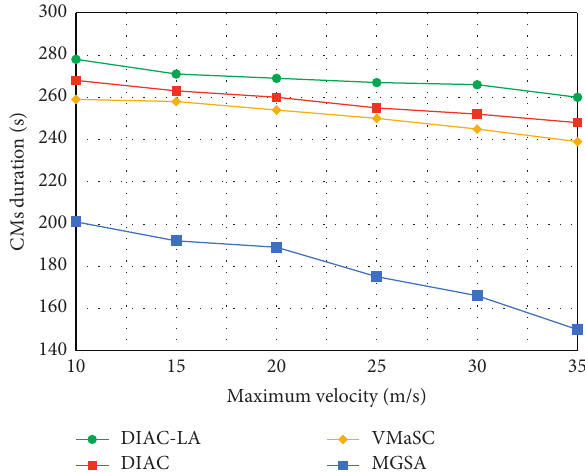
Figure 5: Comparison of DIAC with and without SLCA.